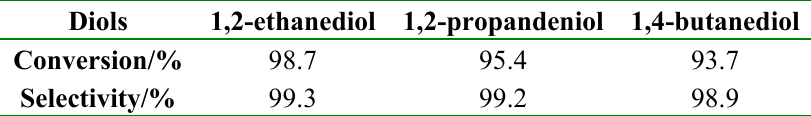
Table 4. The results of various diols.